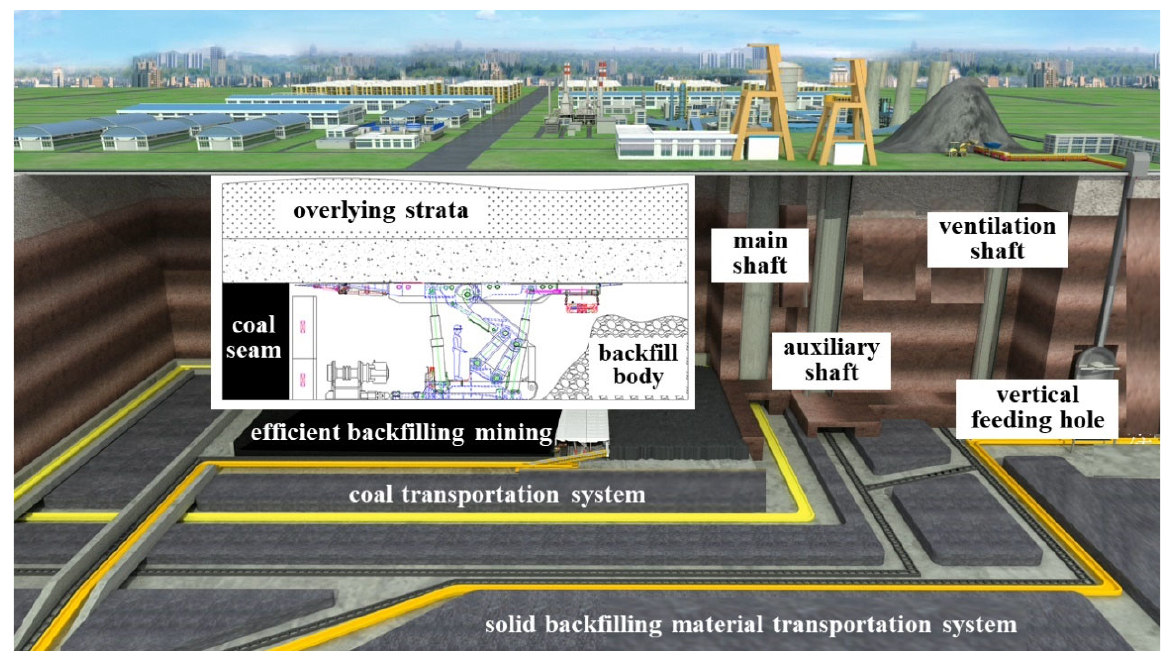
Figure 6. Schematic diagram of high ‐ efficiency gangue backfilling technologies.